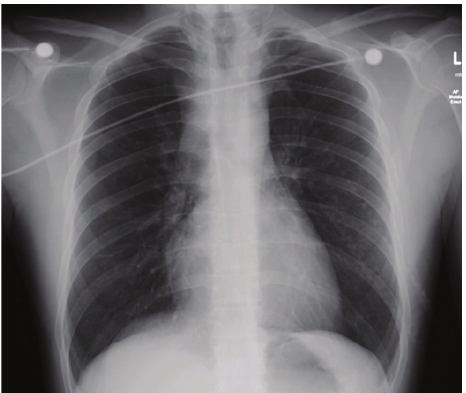
Figure 1: CXR on presentation.